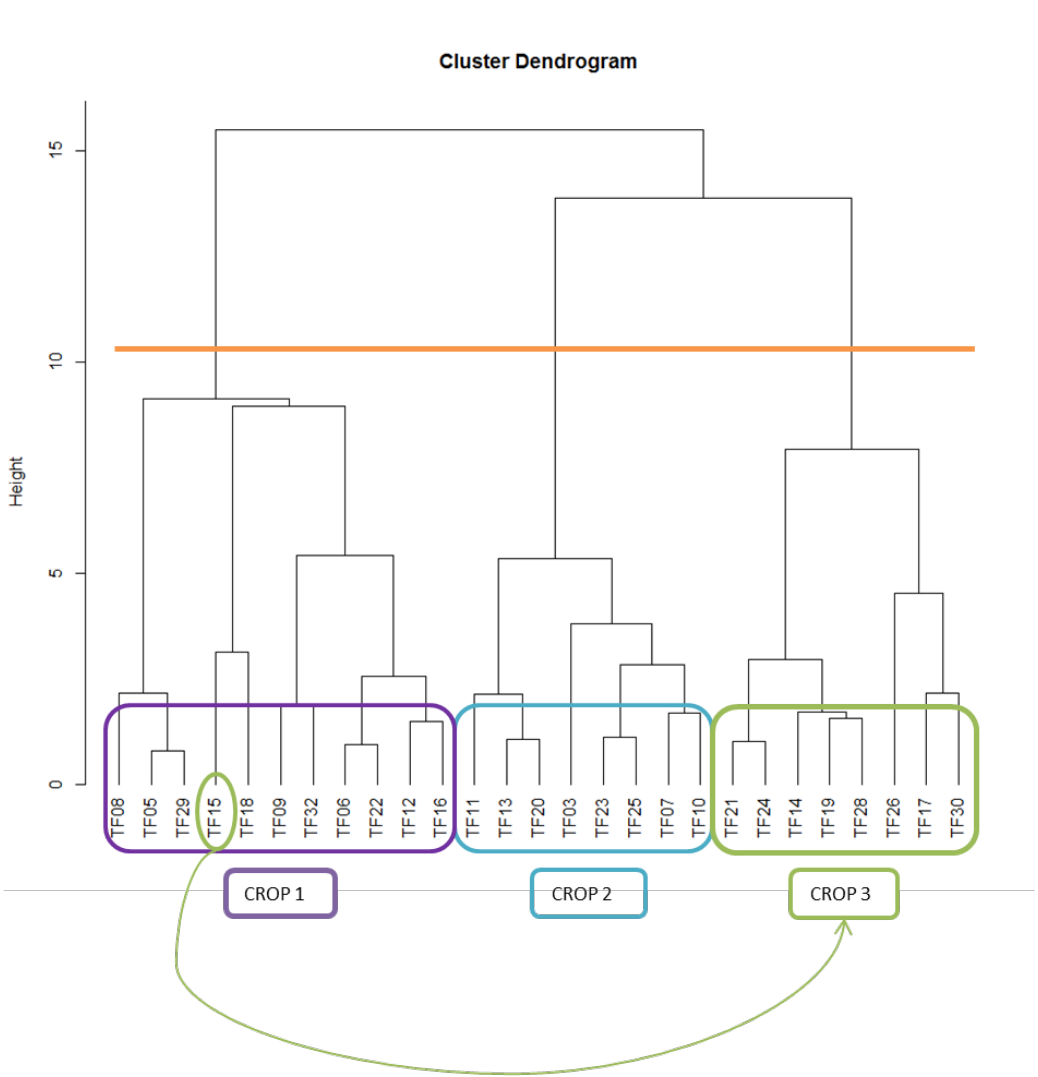
Figure A1.1 Cluster Dendrogram obtained from the AHC on the scores of famers on the axes of the multivariate analysis on cropland management